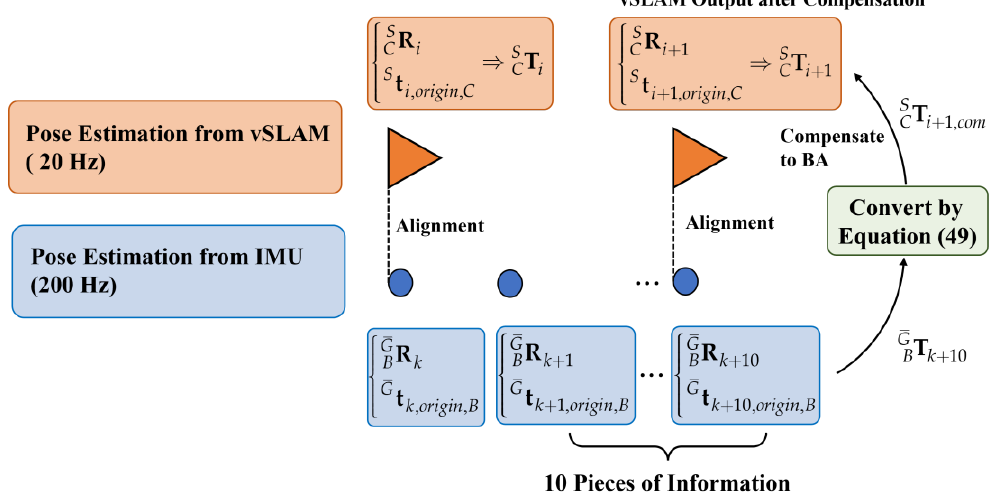
Figure 17. Alignment between vSLAM and IMU data.